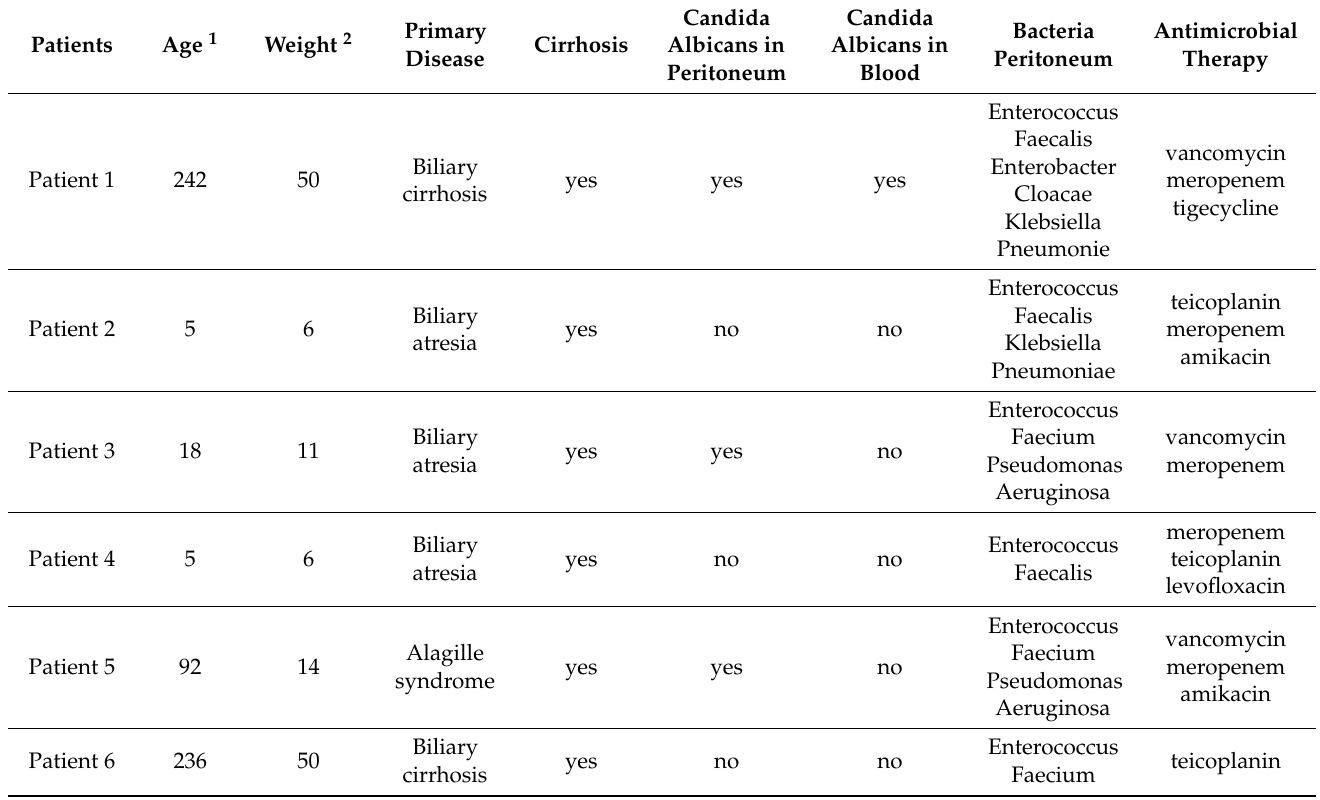
Table 1. Patient demographic